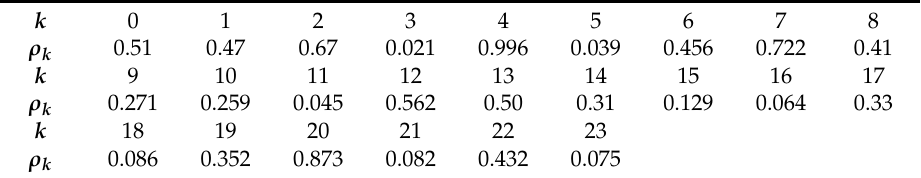
Table 9. The probability distribution of ρ during the finite horizon.